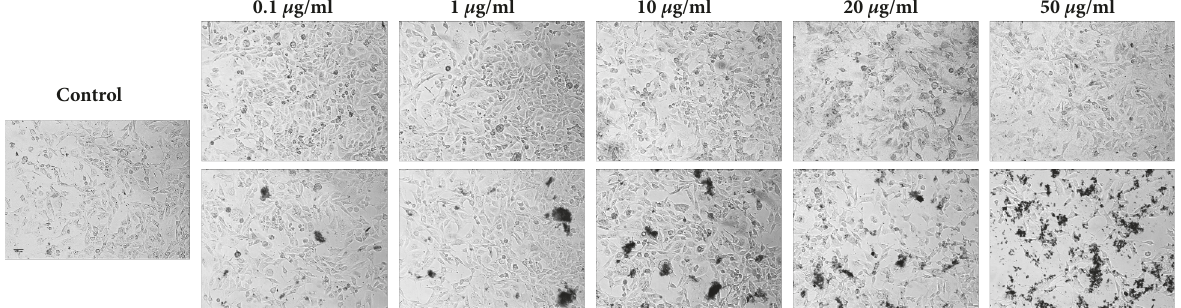
Figure 4: Phase contrast micrographs of A549 cells incubated 24 hours in the presence of GO (upper panel) and GO-NH 2 (lower panel) nanoparticles at different concentrations. Magnification 10x.